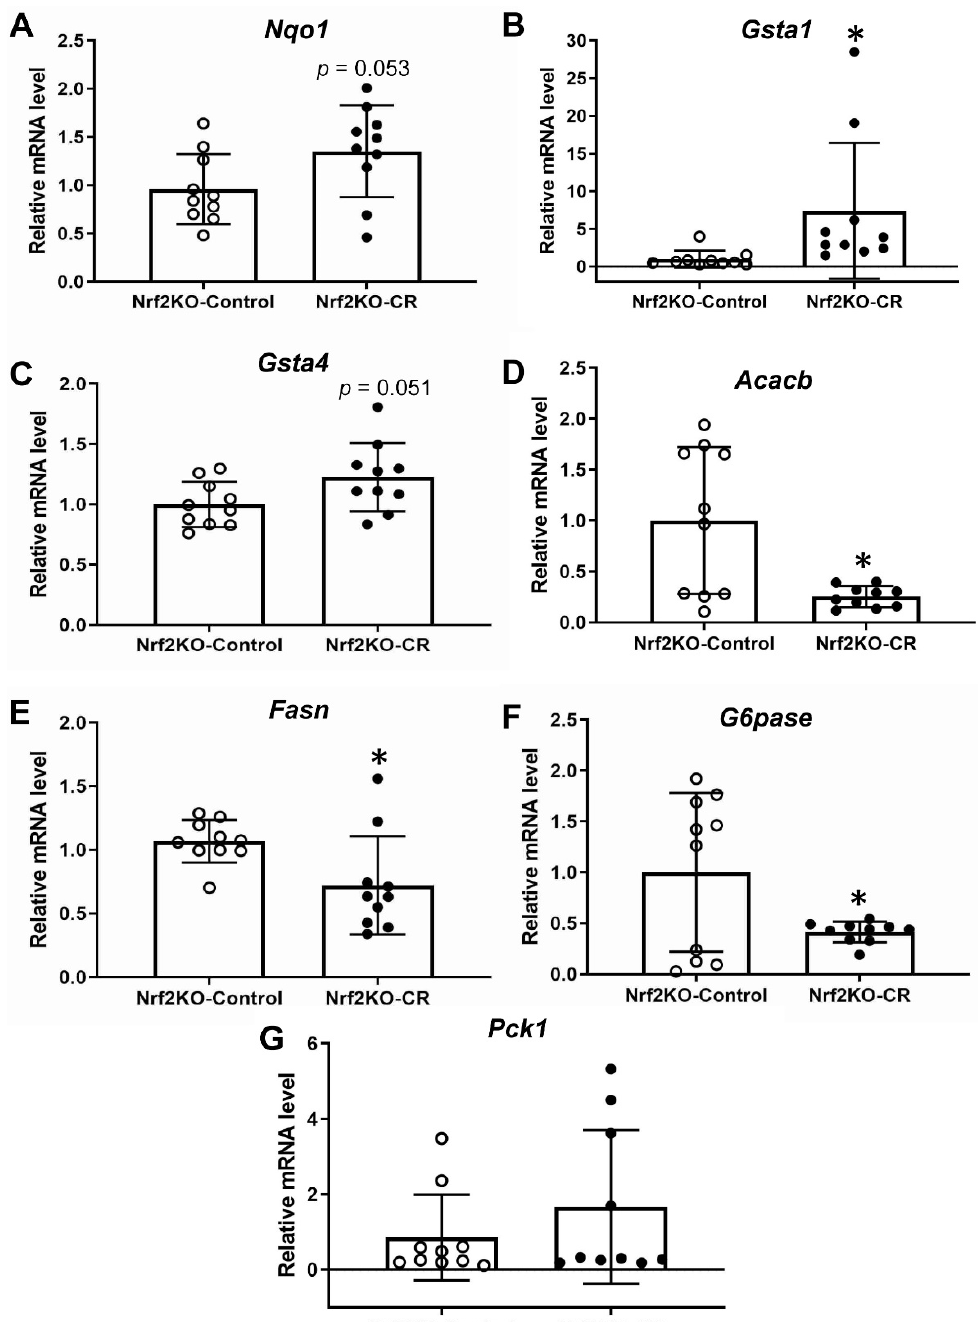
Figure 6. Relative mRNA expression of cytoprotective/antioxidant (Nqo1 ( A ), Gsta1 ( B ), and Gsta4 ( C )); key lipogenic (Acacb ( D ), Fasn ( E )); and gluconeogenic enzymes (G6pase ( F ); Pck1 ( G )) in Nrf2 knockout embryos. n = 10 per group, * p < 0.05. Nrf2KO ‐ Control: Nrf2 knockout embryos fed ad libitum; Nrf2KO ‐ CR: calorie ‐ restricted Nrf2 knockout embryos.